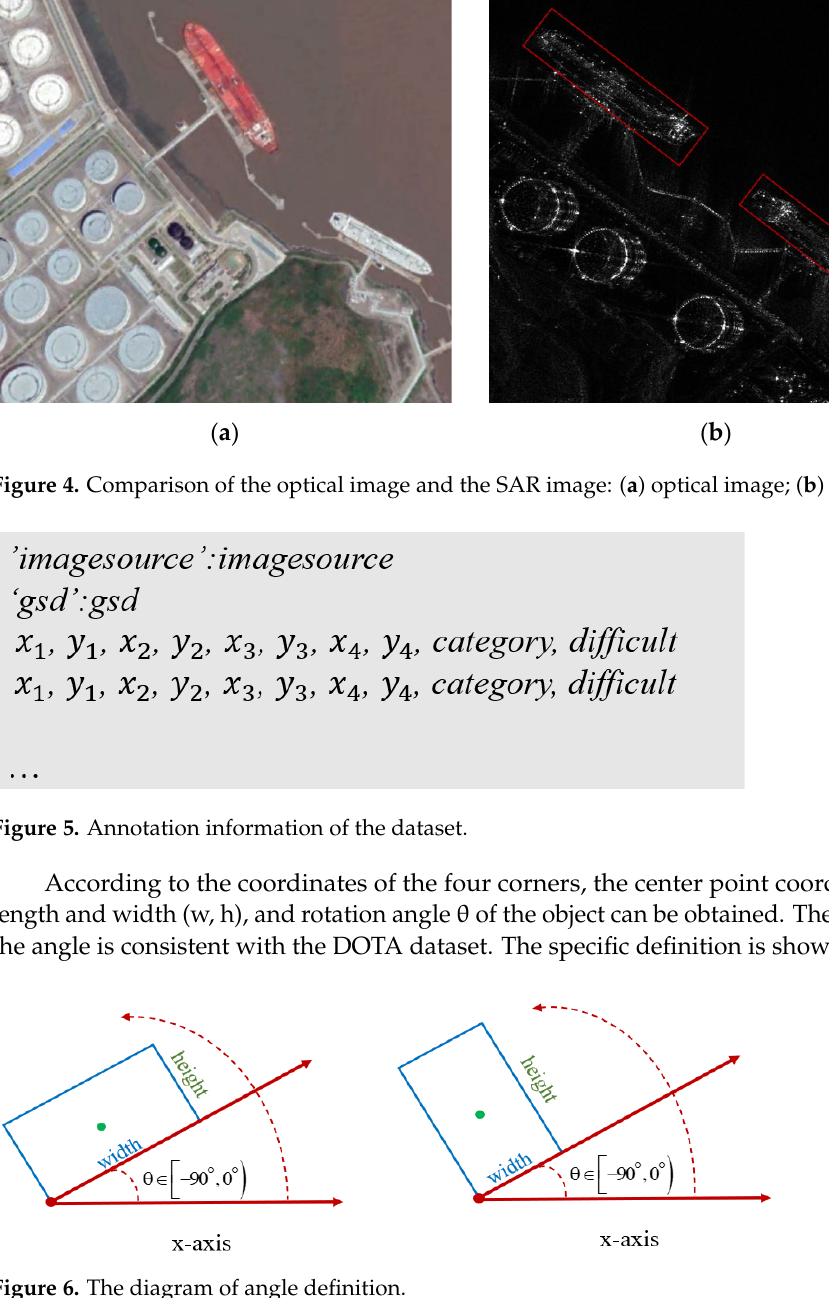
Figure 6. The diagram of angle definition.